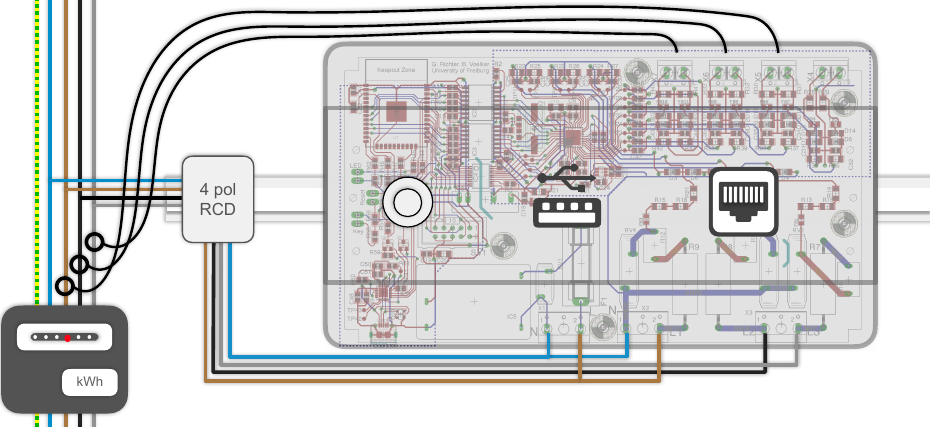
Figure 2. Schematic of the SmartMeter wiring for a three-phase power supply inside the fuse